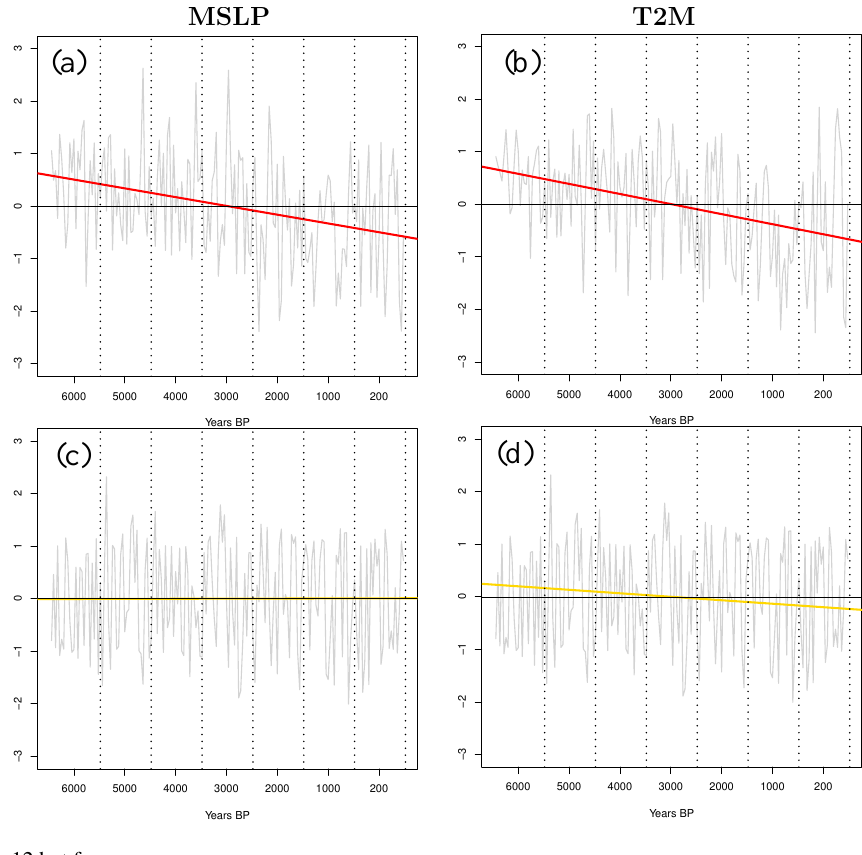
Figure 13. As in Fig. 12 but for